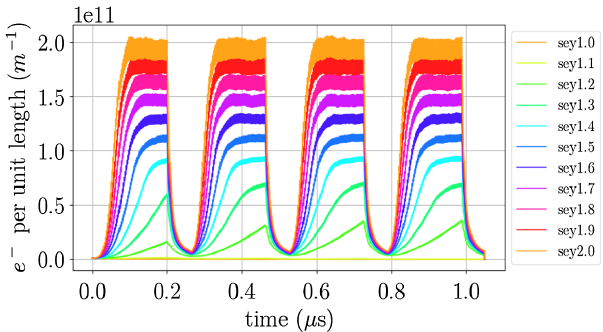
FIG. 1. Evolution of the total number of electrons in the chamber of the FCC-ee arc dipoles as a function of time in the case of 2.5 ns bunch